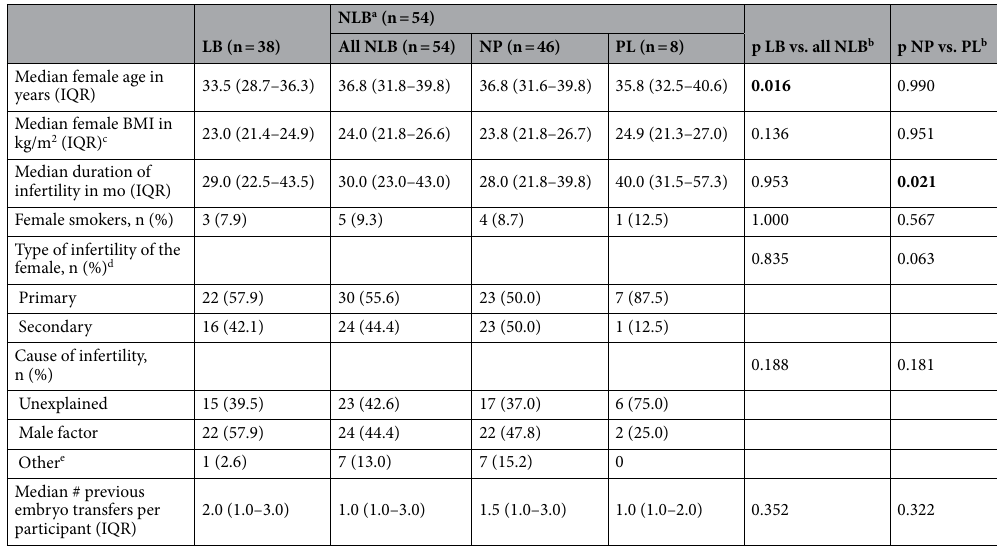
Table 2. Participants characteristics by birth outcome. Significant values are in [bold]. BMI body mass index, IQR interquartile range, LB live birth, mo months, NLB no live birth, NP no pregnancy, PL pregnancy loss. Only samples with ≥ 100 16S rRNA sequencing reads (V1–V2 region) were included. a The NLB participants included participants with a pregnancy loss (PL) as well as participants who did not get pregnant at all (NP). b Continuous variables were compared by Wilcoxon rank sum test and categorical variables by Fisher’s exact test. c Data was missing for one participant in the LB group. d Primary: female has never conceived before. Secondary: female has conceived before. e Other causes of infertility are tubal factor (NLB n = 1), ovulatory disorder (LB n = 1, NLB n = 2), endometriosis (NLB n = 1) and mixed causes (NLB n =